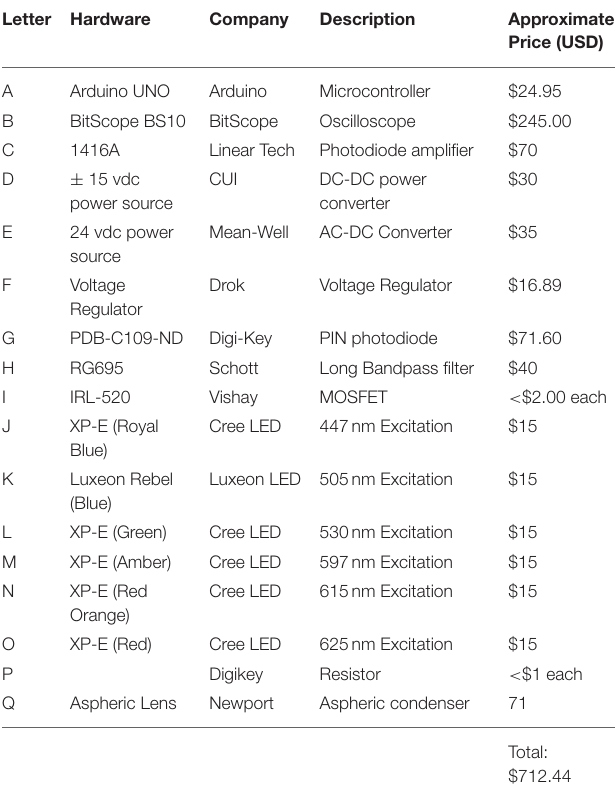
TABLE 1 | Equipment list for fluorometer build.